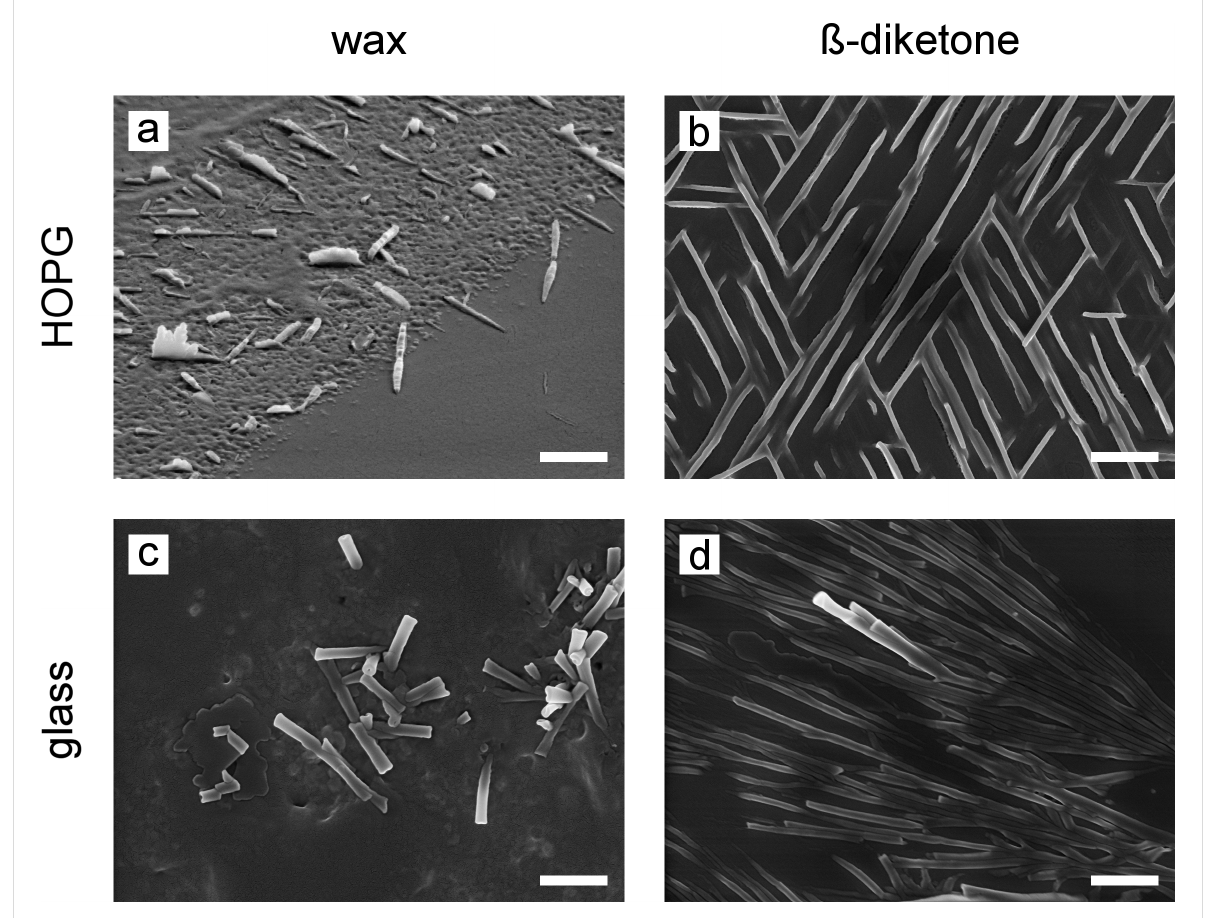
Figure 2: SEM micrographs of wax and ß-diketone recrystallized on HOPG and glass after three days. Left column: wax solution; right column: ß-di- ketone solution. (a) Tilted SEM micrograph of irregular platelets parallelly oriented in acute angles. (b) Network-like structure made of platelets. (c) Vertically protruding tubules, and (d) horizontally grown tubules. Scale bars: 2